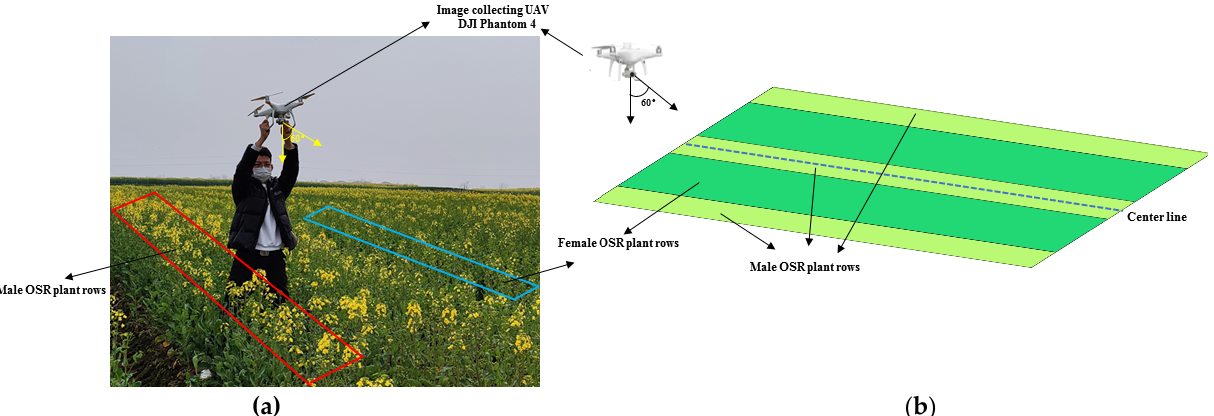
Figure 1. OSR plant image collecting in the test field; ( a ) Static manual holding photography; ( b ) Low altitude hovering photography.